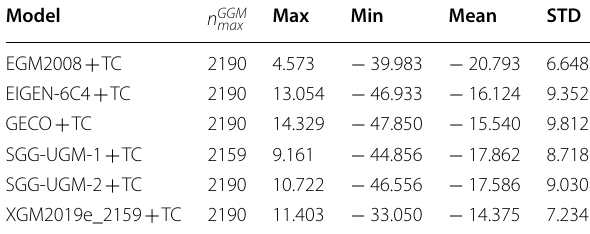
Table 5 The statistics of the differences between the gravity anomaly derived from gravity field models and the measured data after terrain correction in Sichuan Basin (unit: mGal)